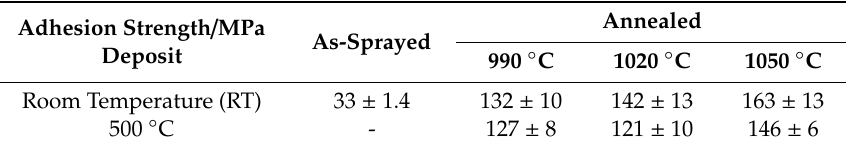
Table 6. Adhesion strength of the coatings.